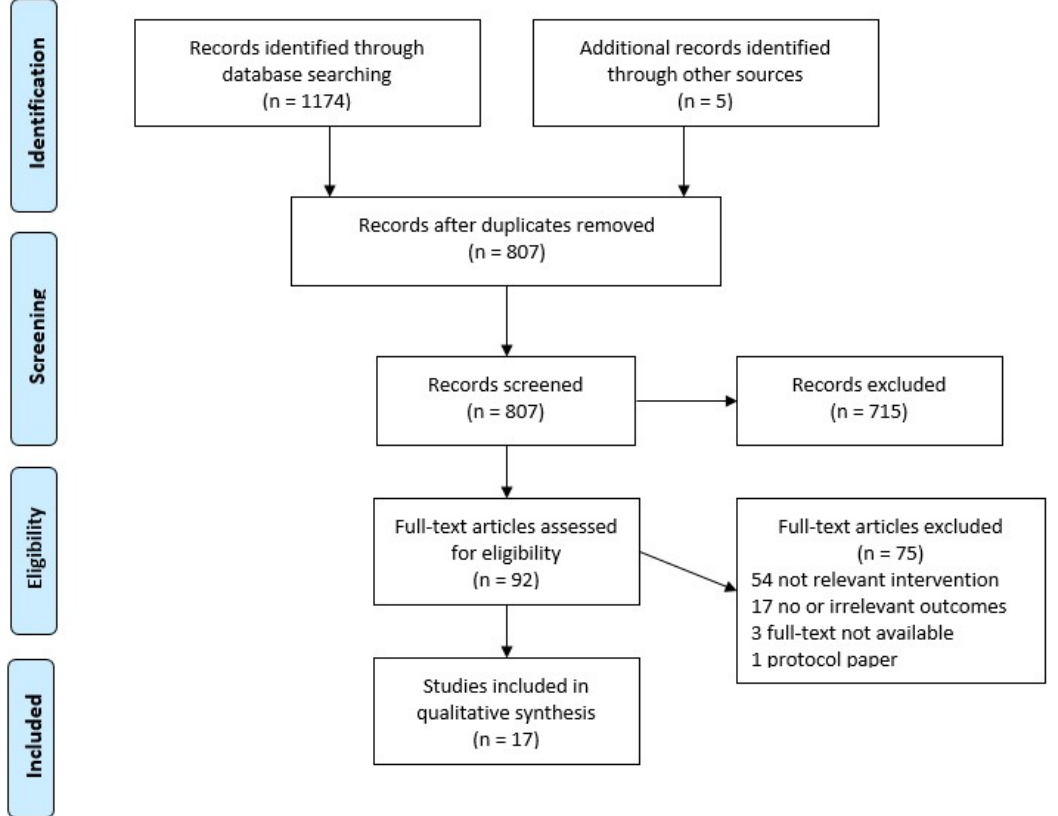
Figure 2. A flowchart of the database searches, screening and selection of articles according to the PRISMA statement (www.prisma-statement.org).